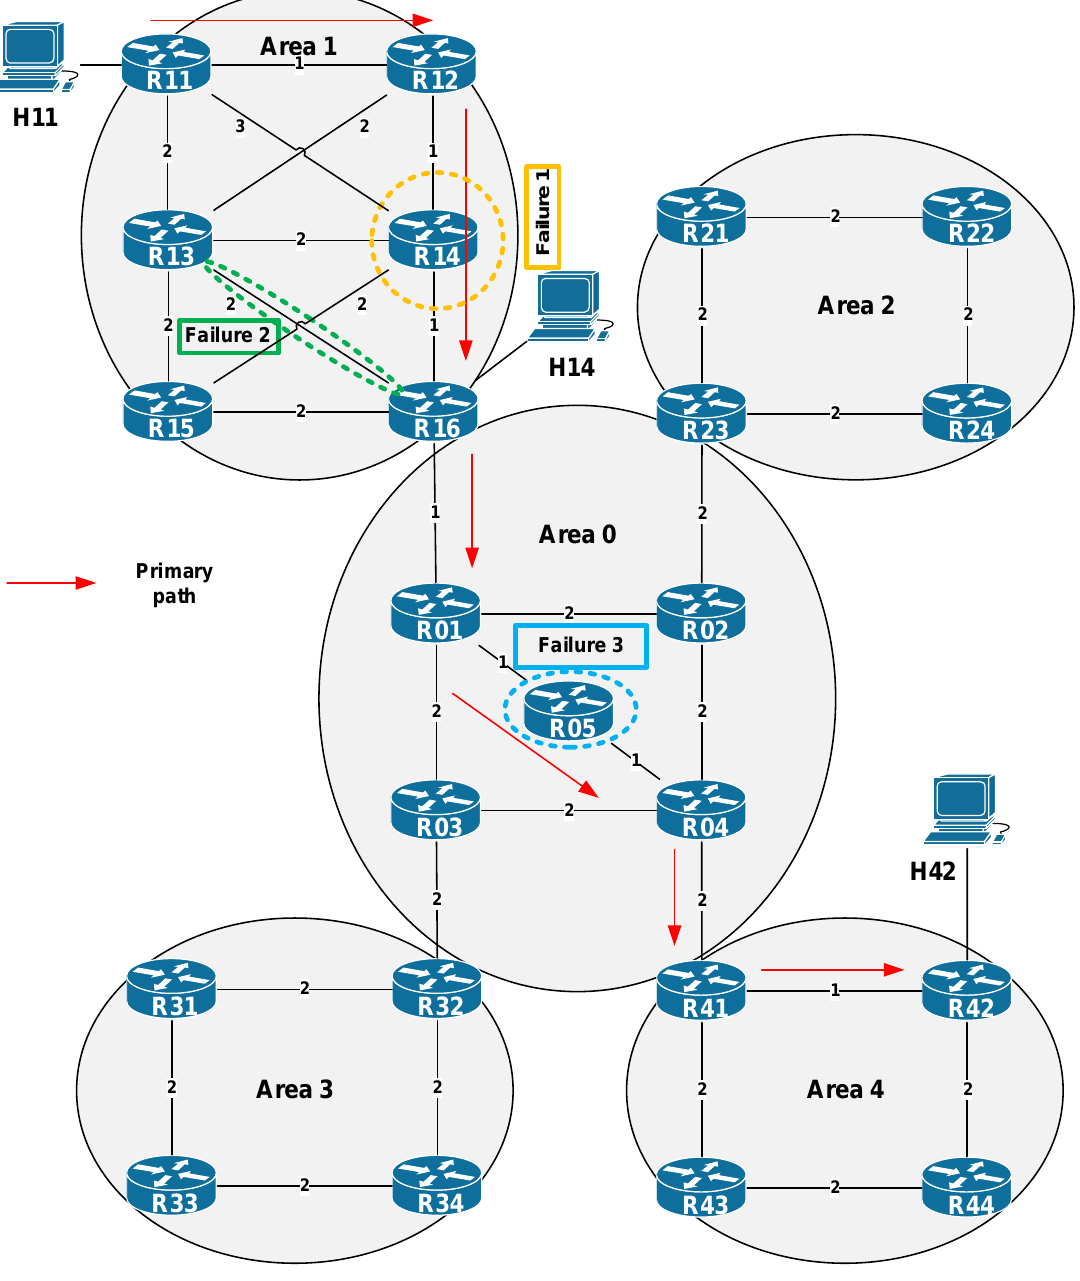
Figure 13. The OMNeT++ simulation topology.